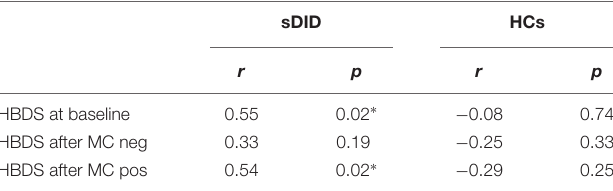
TABLE 4 | Correlation between cardiac vagal tone (lnRMSSD) and interoceptive accuracy (heartbeat detection score). sDID HCs r p r